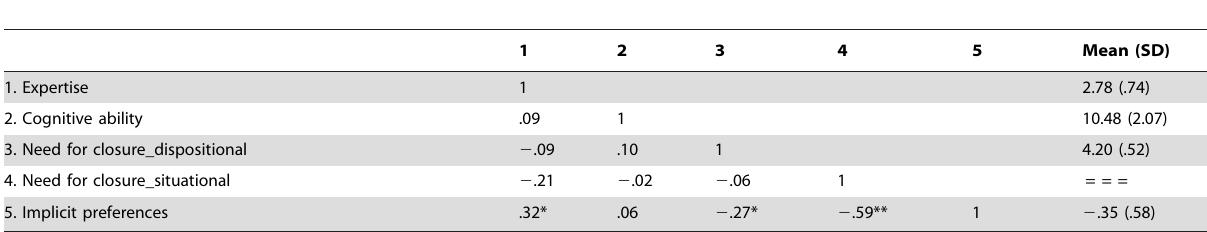
Table 4. Study two: Means, standard deviations and correlations among